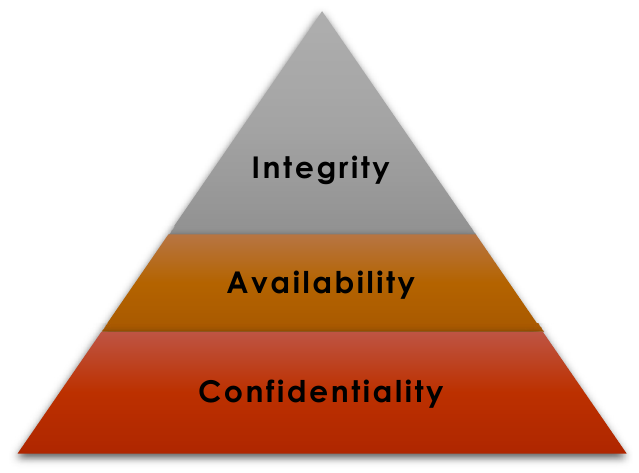
Figure 1. The CIA Triad.